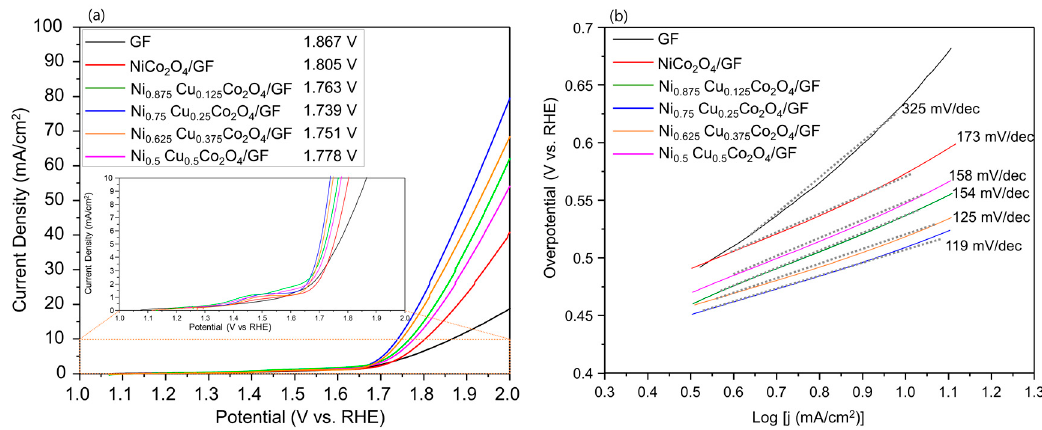
Figure 6. Linear scan voltammetry (LSV) curves for oxygen evolution reaction (OER) polarization of Ni 1 − x Cu x Co 2 O 4 / GF ( a ) and Tafel plots ( b ). Table 2. Comparison of electrochemical performances for noble or non-noble metal electrodes.